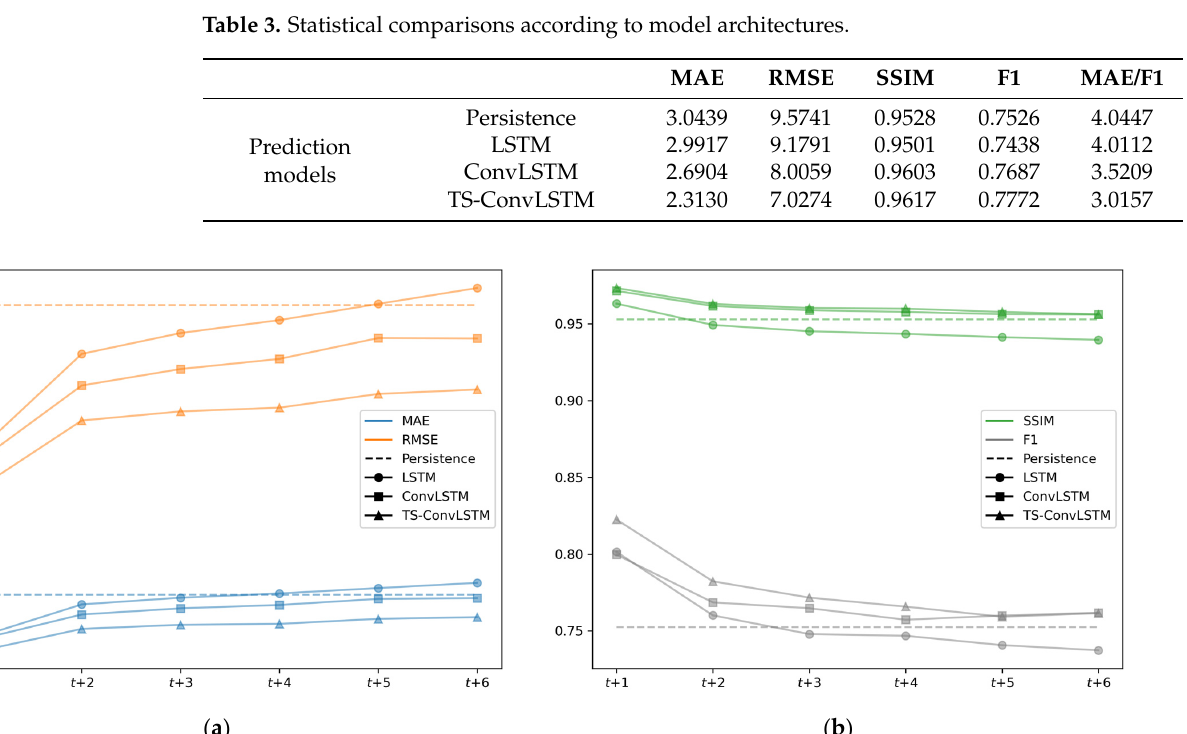
Table 4. Statistical comparisons according to loss functions.